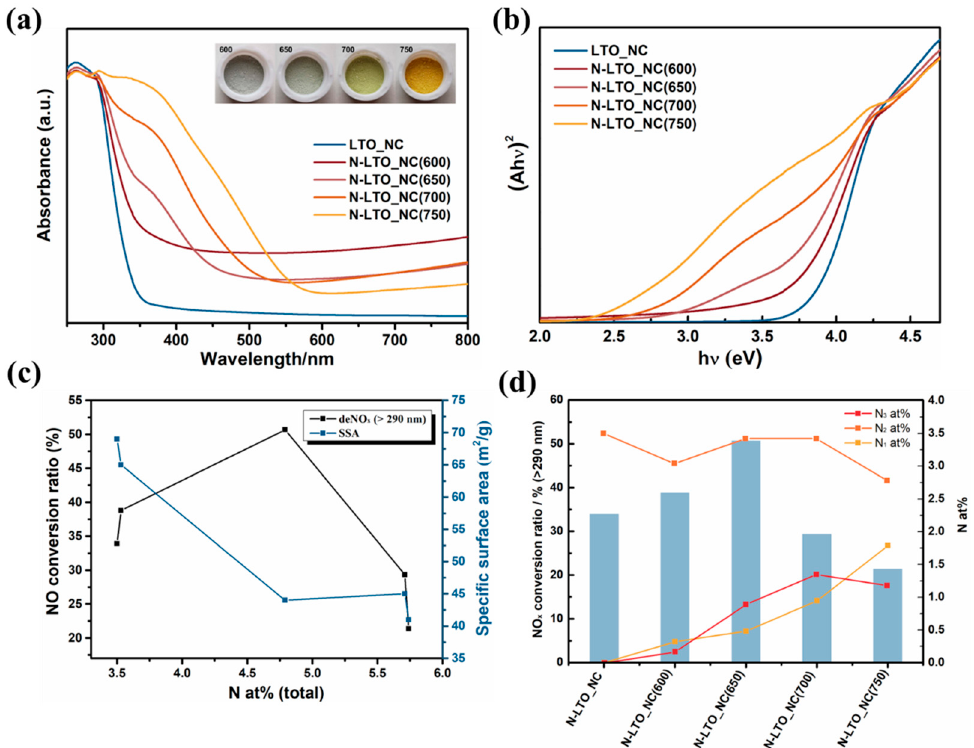
Figure 1. ( a ) UV–vis diffuse reflectance spectra, ( b ) Tauc plots of N-doped La 2 Ti 2 O 7 , ( c ) the relations of total nitrogen amount (at%) with NO conversion ratios and specific surface areas, and ( d ) correlation between the photocatalytic NO conversion ratio of La 2 Ti 2 O 7 precursor, N-doped La 2 Ti 2 O 7 under different calcination temperature (600–750 °C) and different nitrogen sites (N1: substitutional N with N-Ti-N bond, N2: substitutional N with N-Ti-O bond, and N3: interstitial N) [31]. (Reproduced from Ref. [31] with permission from the Elsevier).